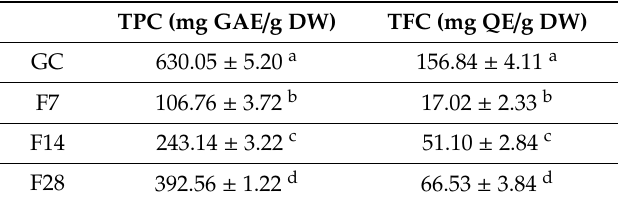
Table 1. Total phenolic (TPC) and flavonoids (TFC) content in green co ff ee extract and green co ff ee ferments (DW—dry weight of ferments or extract, GAE—gallic acid,